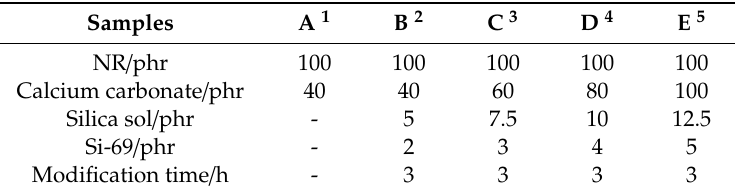
Table 1. Experimental